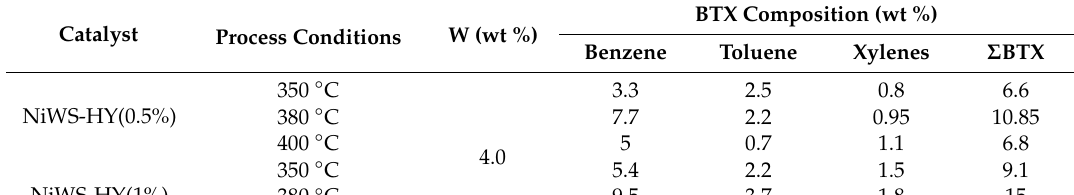
Table 2. Dependence between component composition of the BTX fraction and temperature at standard conditions.